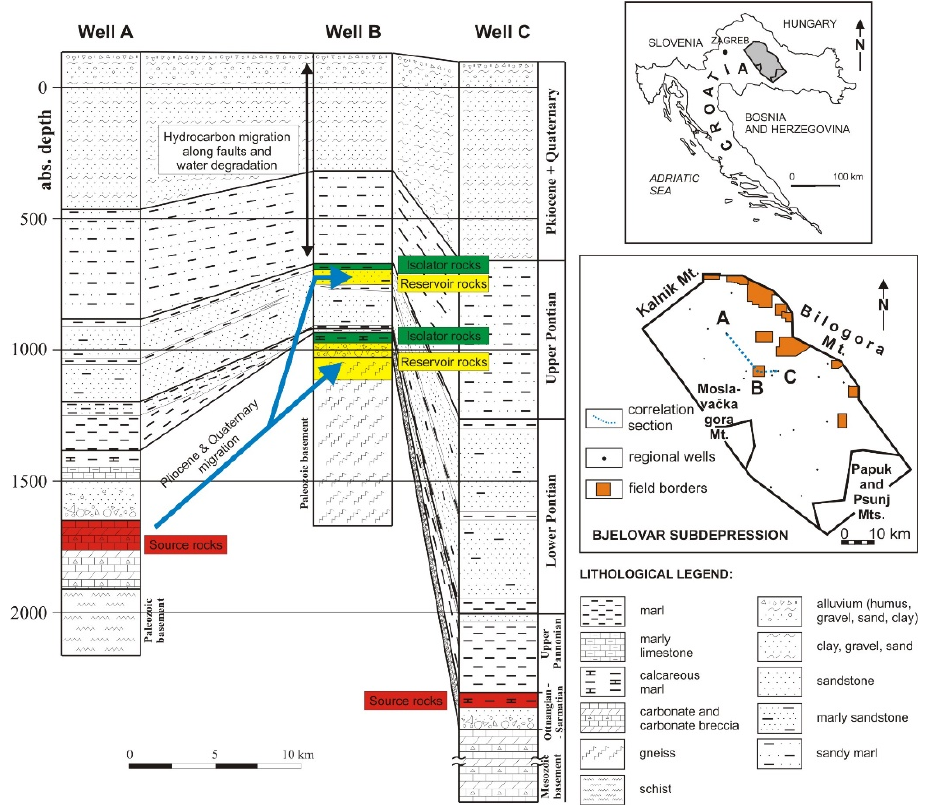
Figure 1. Location and typical hydrocarbon system in the Bjelovar Subdepression [5–7].